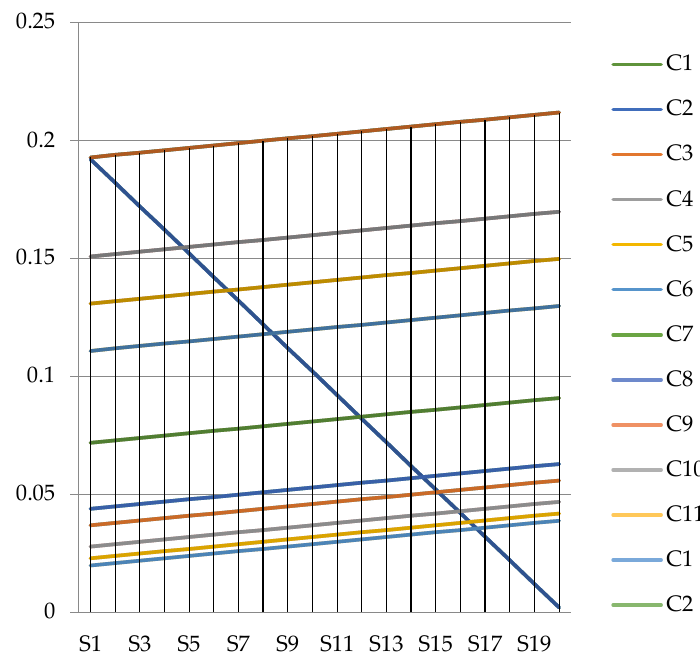
Figure 2. Scenarios with different weight coefficients of criteria.